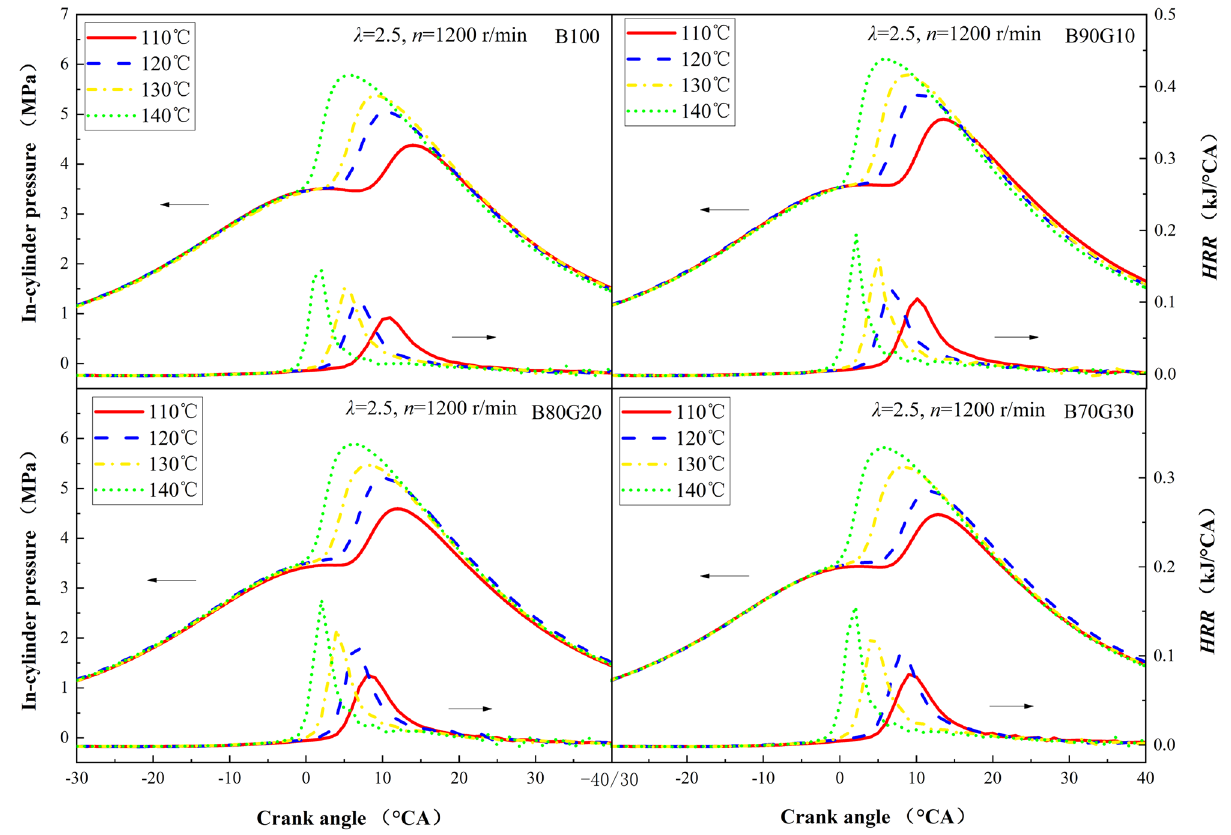
Figure 11. In-cylinder pressure and HRR with different T in